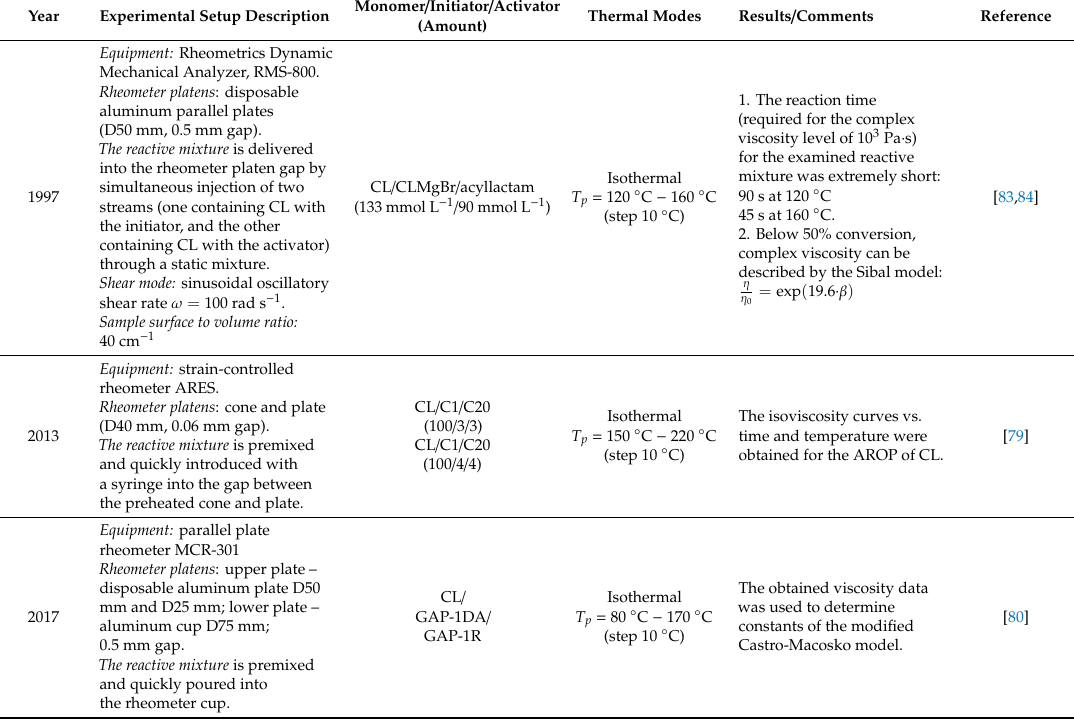
/ Initiator / Activator (Amount) Thermal Modes